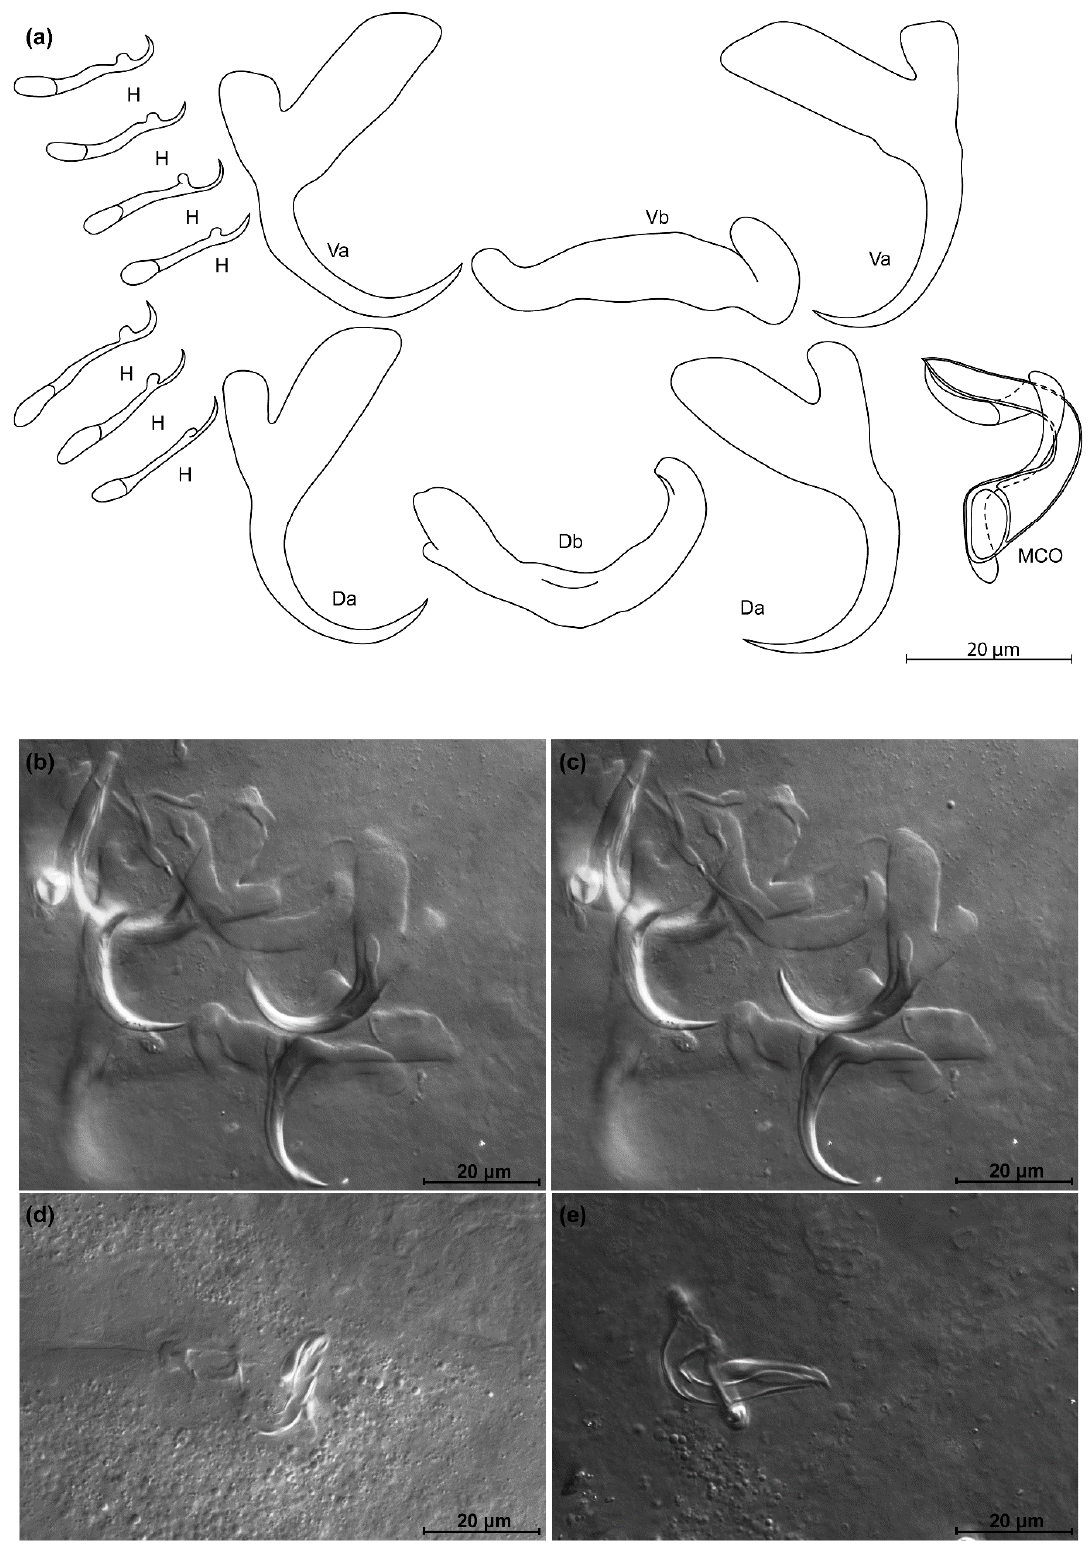
Figure 12. Kapentagyrus verbisti n. sp. (ex Pellonula leonensis ). ( a ) Drawings of sclerotized structures, Va-ventral anchors, Da-dorsal anchors, Db-dorsal bar, Vb-ventral bar, H-hooks (hook pair not identified), MCO-male copulatory organ. ( b ) Micrograph of dorsal anchors and dorsal bar. ( c ) Micrograph of ventral anchors and ventral bar. ( d ) Micrograph of MCO. ( e ) Micrograph of MCO (not from the holotype).